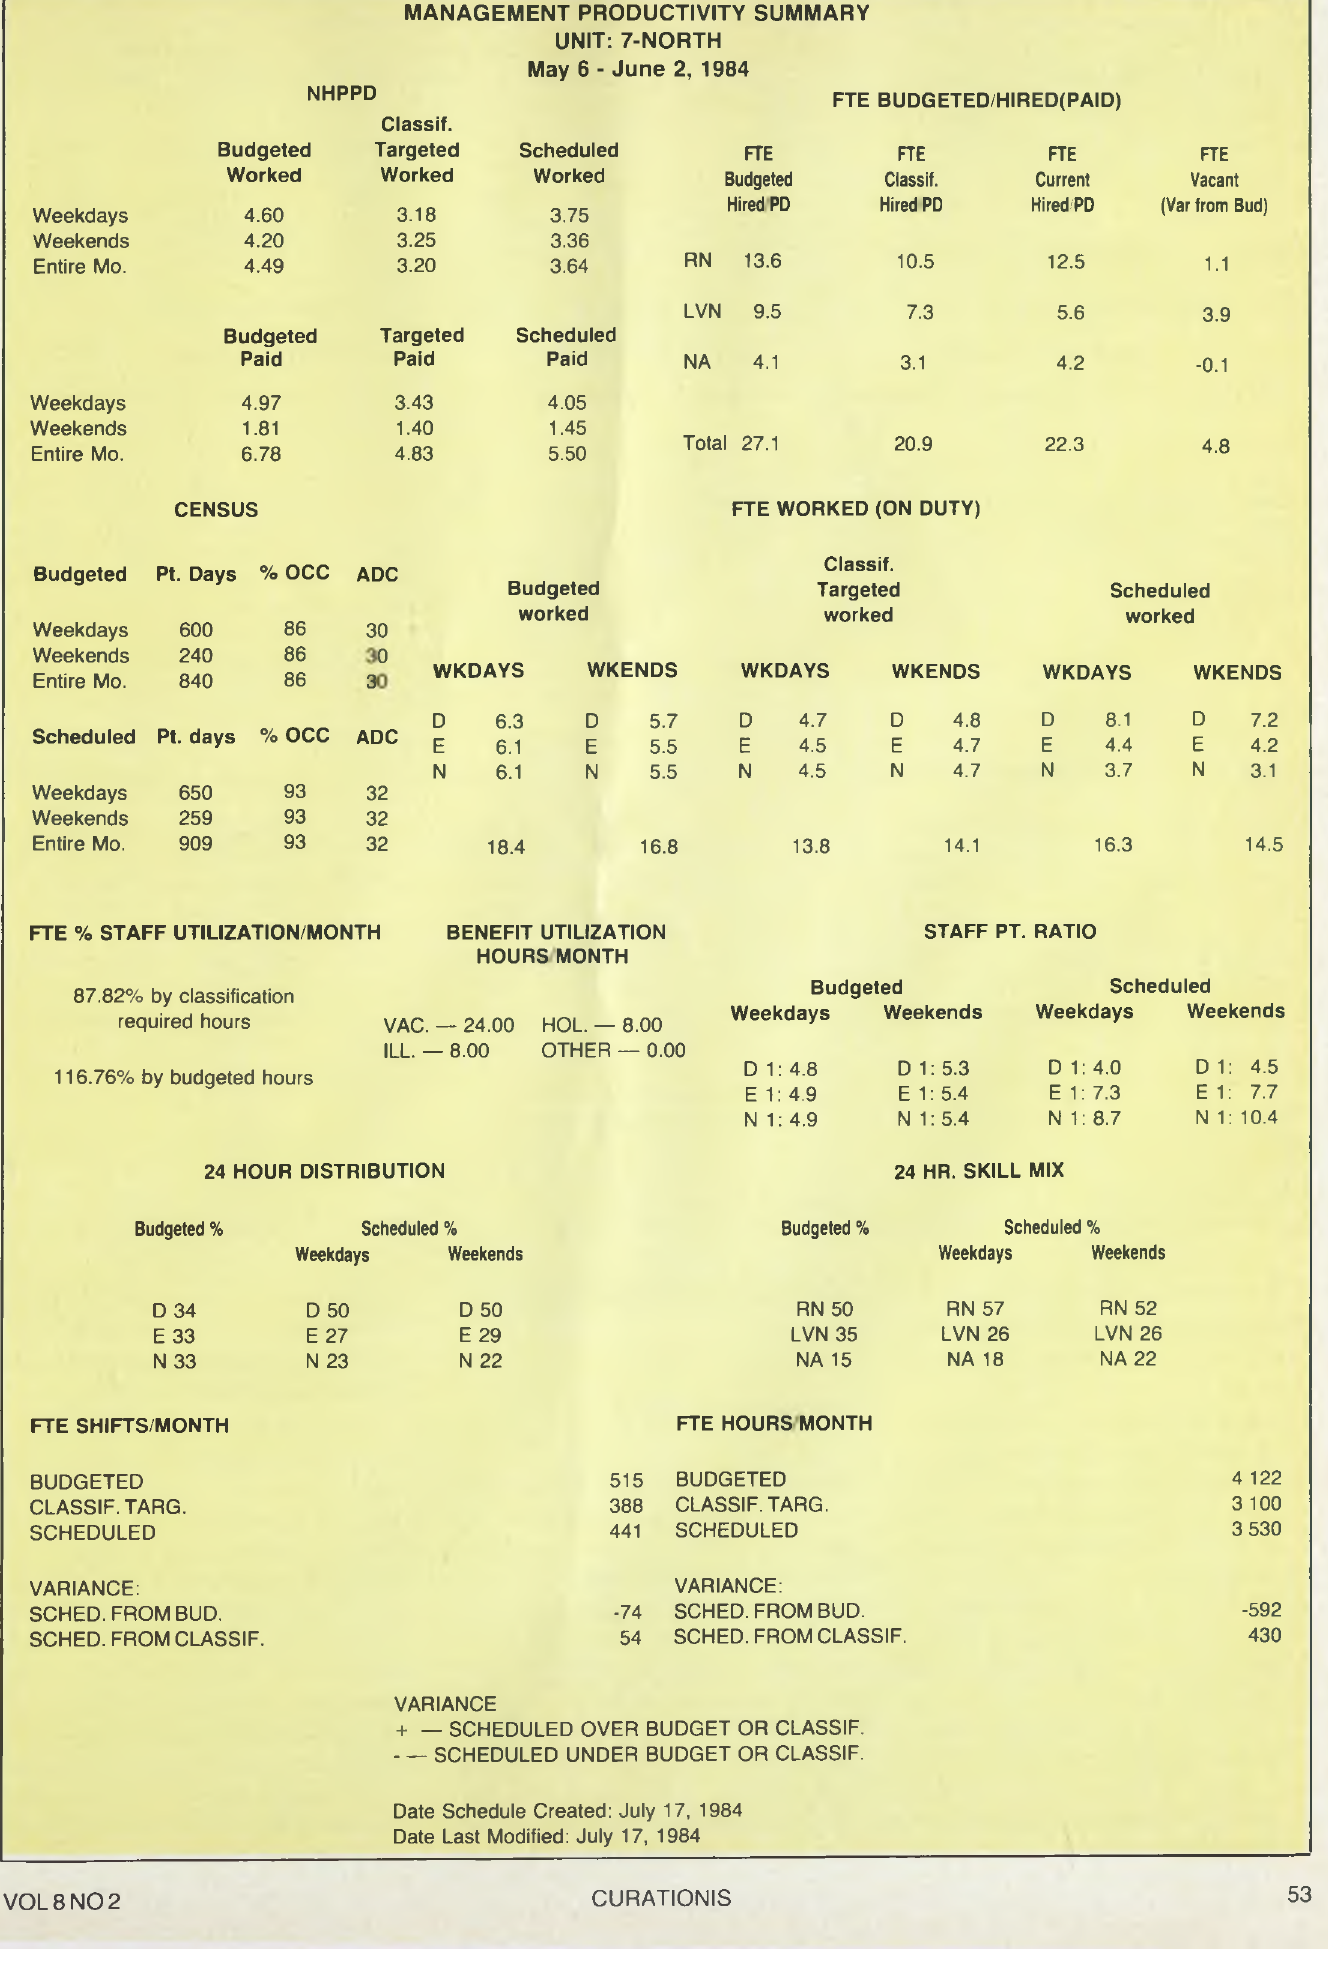
FIGUUR 4 Produktiwiteitsverslag oor 4